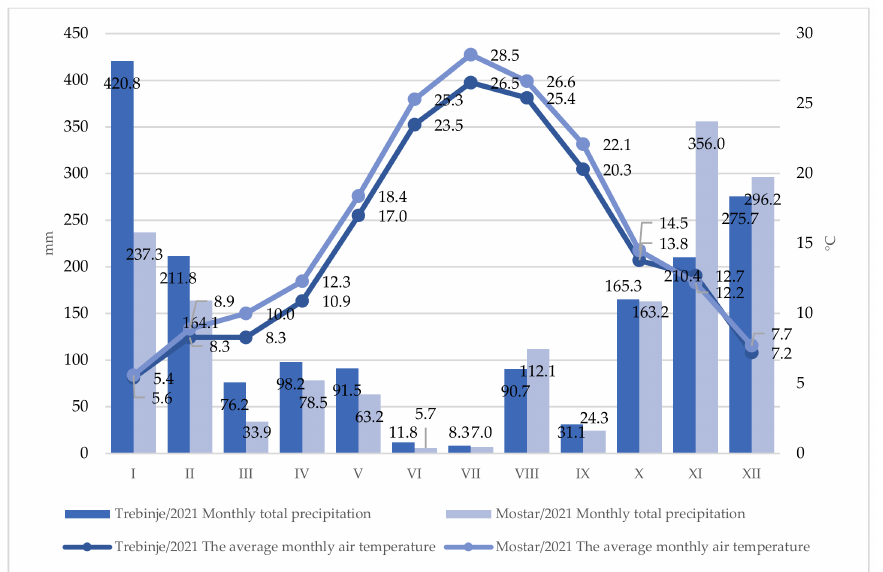
Figure 2. Climatic conditions (total rainfall and average air temperature) at Trebinje and Mostar localities during 2021.